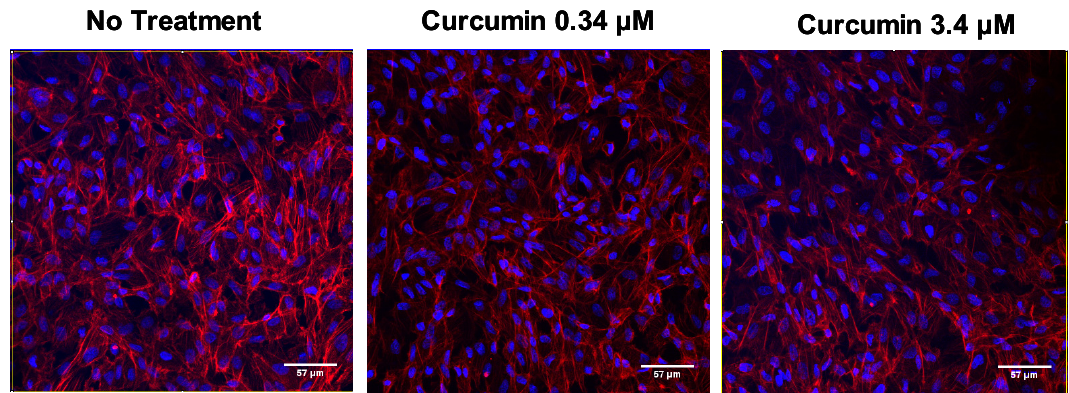
Figure 3. Effect of curcumin on the morphology of ARPE-19 cells. Representative images of DAPI/ Phalloidin labelling in untreated and treated cells with curcumin at 0.34 or 3.4 µM.